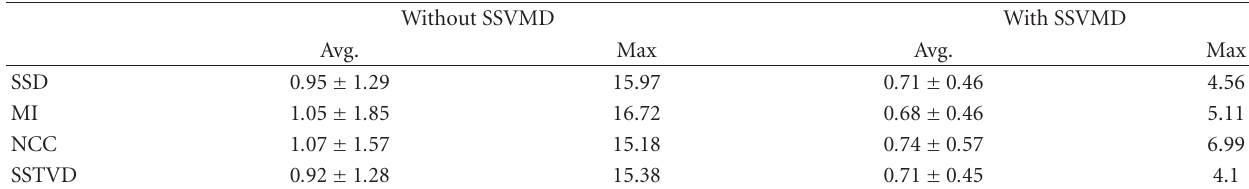
Table 3: Landmark errors (mm) using six subjects.